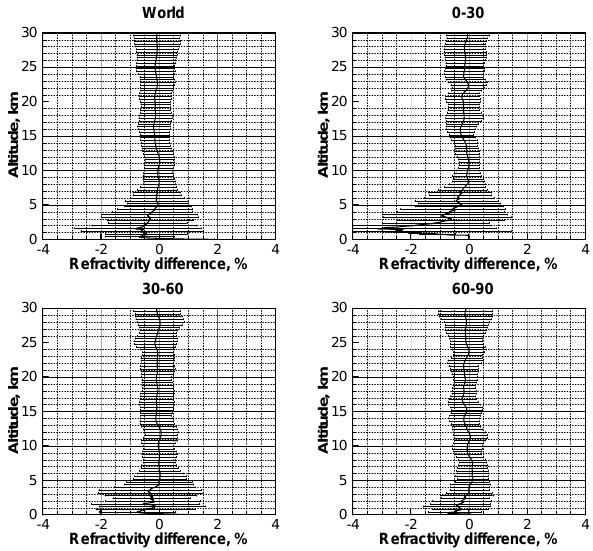
Fig. 7. Statistical comparison of GRAS CL and ECMWF refrac- Figure 7. Statistical comparison of GRAS CL and ECMWF refractivities for September 30, 3 tivities for 30 September 2007: the whole globe (“World”), tropics 2007: the whole globe (‘World’), tropics (‘0–30’), mid-latitudes (‘30–60’), and polar latitudes 4 (“0–30”), mid-latitudes (“30–60”), and polar latitudes (“60–90”). (‘60–90’). 5